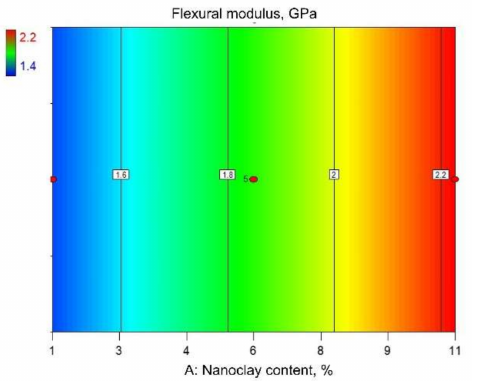
Figure 9. Contour view of reduced quadratic regression model: flexural